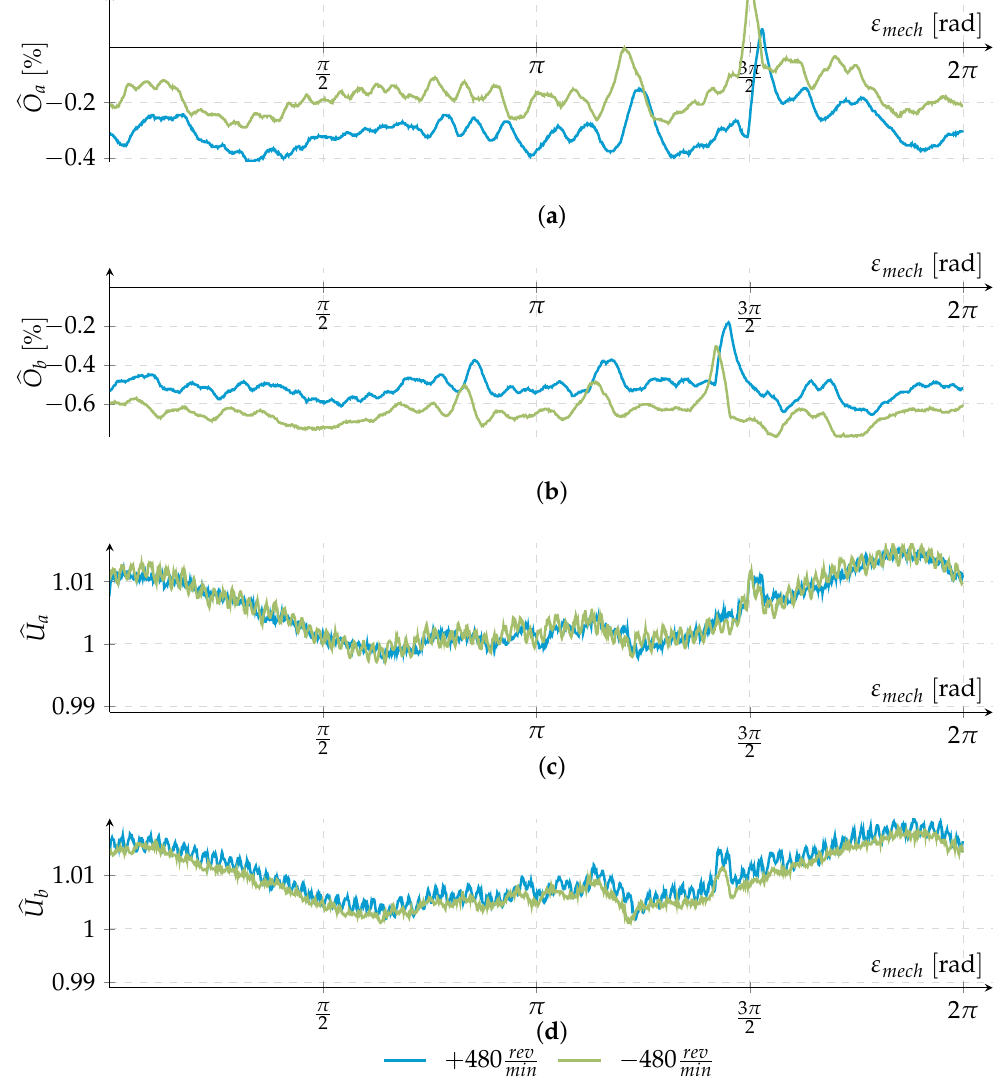
Figure 6. Experimental results of the Harmonic Error Correction of ( a ) the offset of line A ; ( b ) offset of line B ; ( c ) amplitude of line A and ( d ) amplitude of line B (2048 line cycles per